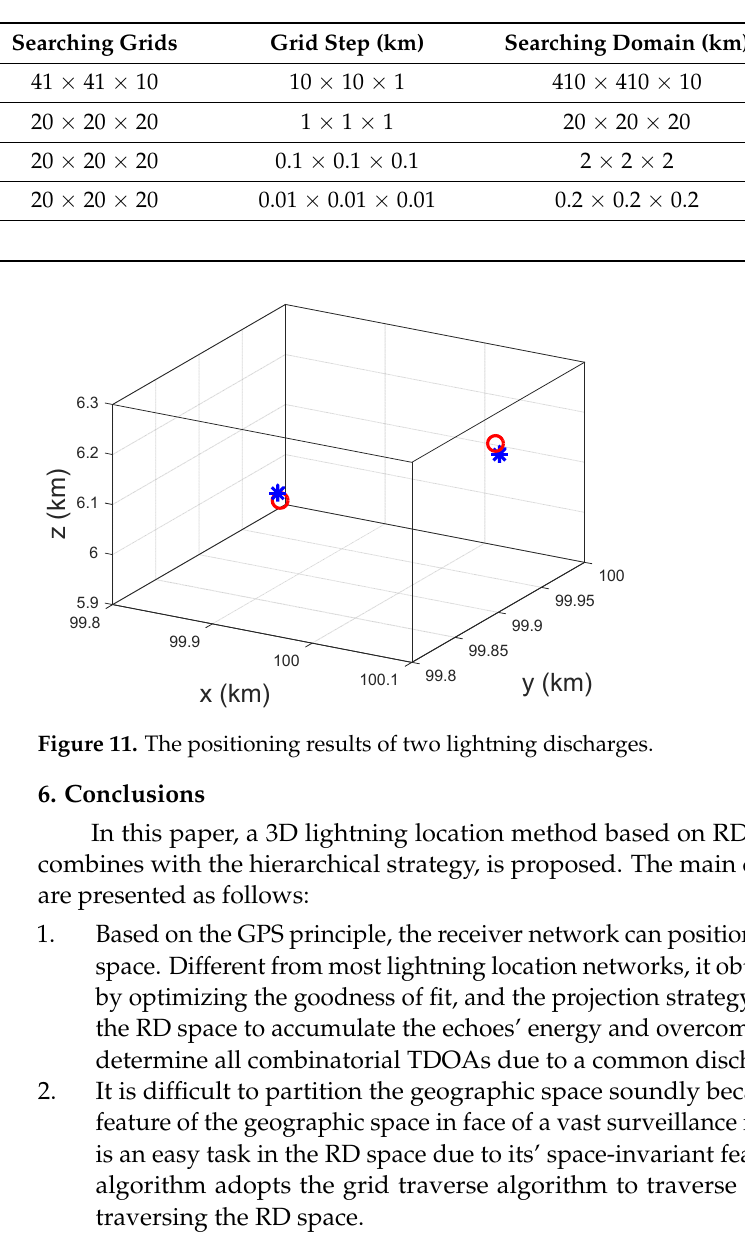
Table 3. The processing time of one receiver.